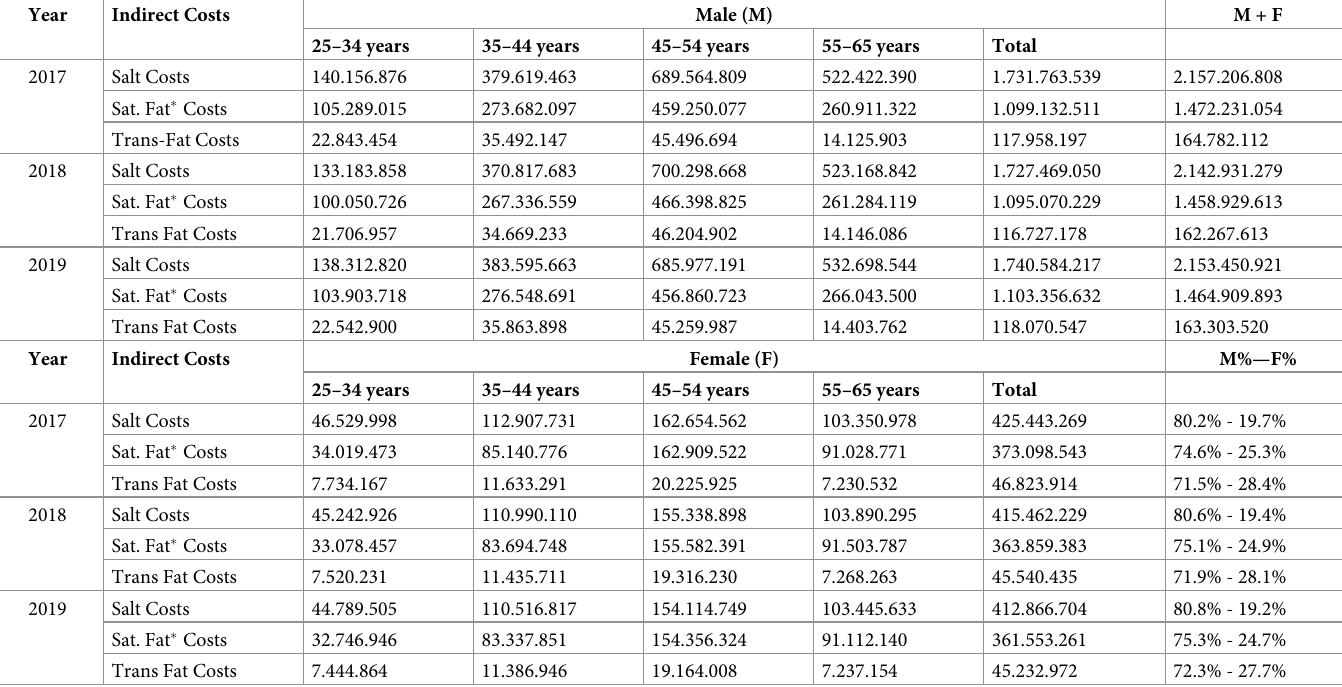
Table 3. Indirect costs attributable to excess consumption of nutrients (salt, saturated fat and trans-fat) by sex and age group in US$.